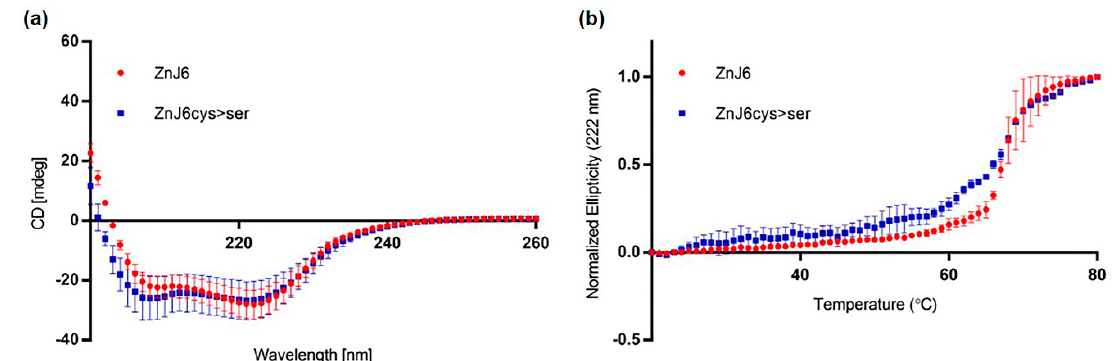
Figure 2. Recombinant ZnJ6 and ZnJ6cys > Ser-mutants are folded and stable up to 65 ◦ C. ( a ) Circular dichroism (CD) single accumulation spectra (ellipticity represented in mdeg), ranging between 200 and 260 nm, were recorded for the ZnJ6 and the ZnJ6cys > Ser-mutant at RT to verify that the recombinant proteins are folded; ( b ) The single wavelength melting curve was generated at a constant wavelength of 222 nm at a temperature range of 20 to 80 ◦ C. Normalized CD melting curves of ZnJ6 and Cys-mutant with relative values between 1.0 and 0.0 provide an overall comparative indication of the thermal stability of ZnJ6 and its ZnJ6cys > Ser-mutant. The WT recombinant ZnJ6 shows a more coordinated structure at elevated temperatures, as indicated by the steep slope. However, both proteins have the same midpoint of the melting curve at 65 ◦ C. The figure shows the mean values obtained in three independent biological repeats; error bars show standard deviations.